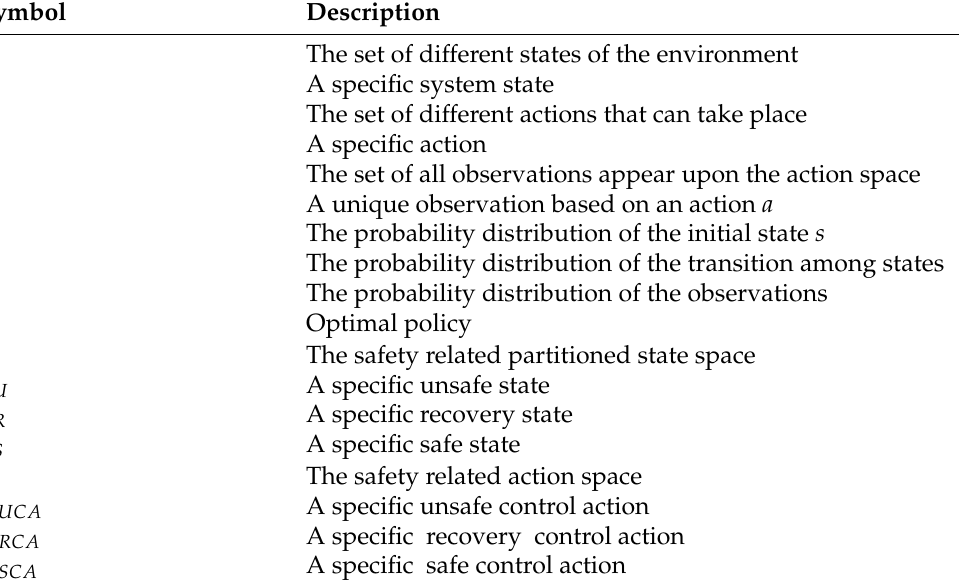
Table 1. Table with mathematical